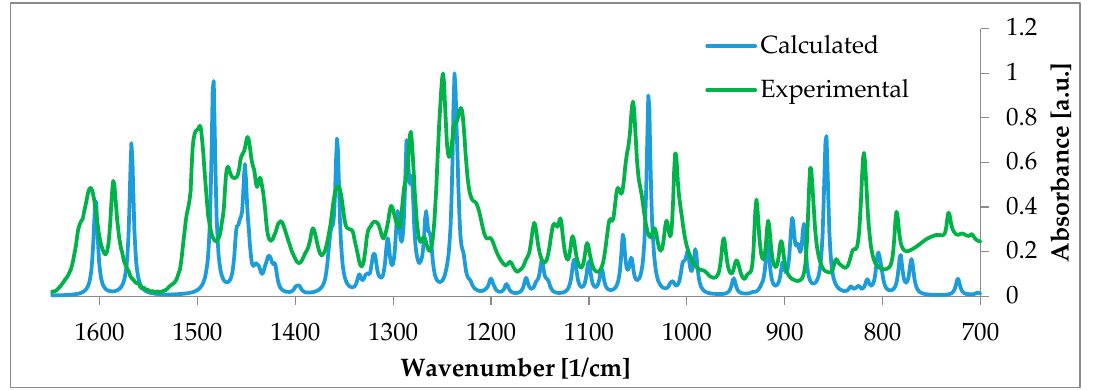
Figure 2. Experimental (green) and calculated (blue) IR spectra of β -estradiol hemihydrate, selected range 700–1650 cm − 1 . Such calculations enable proper band assignments and thus facilitate the spectrum analysis. More information can be found in [158]. Source: Author’s archive.